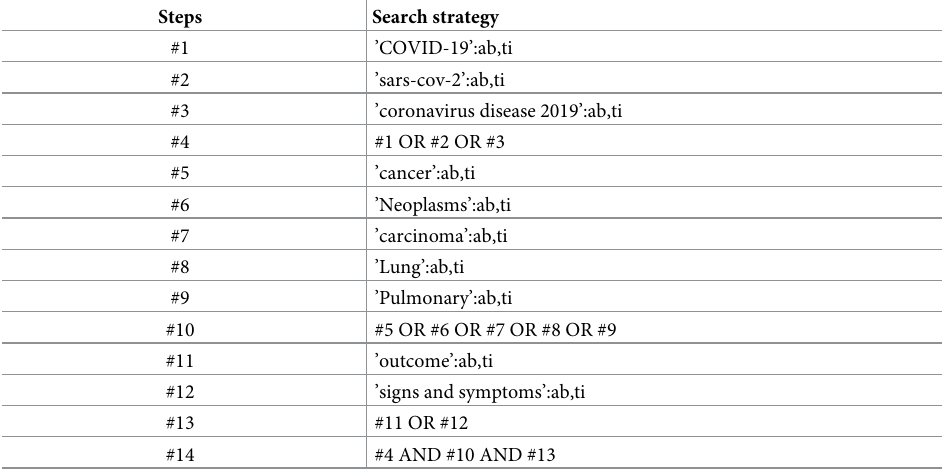
Table 2. Details of the search strategy for